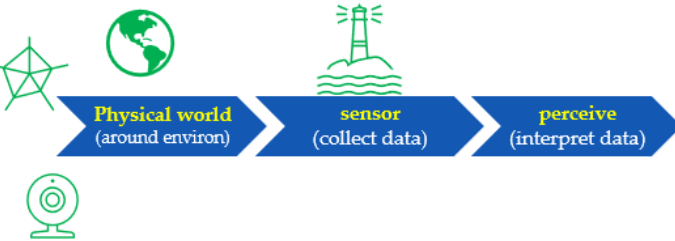
Figure 12. Interpretation of data to make them understandable for users.